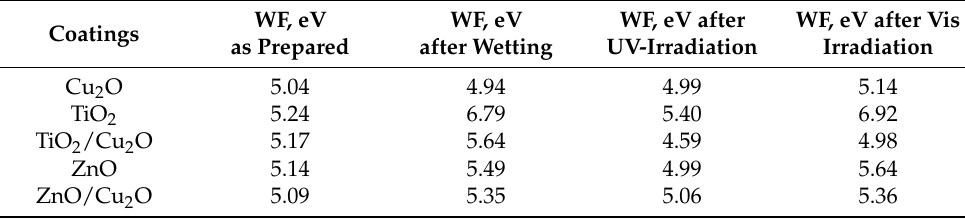
Table 3. Work function values (WF) after different treatments for all studied